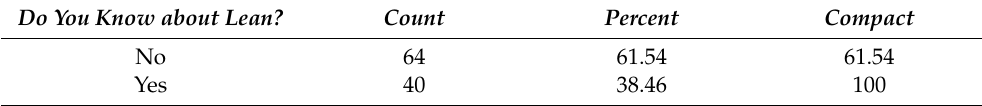
Table 5. Do you know about lean methodology?